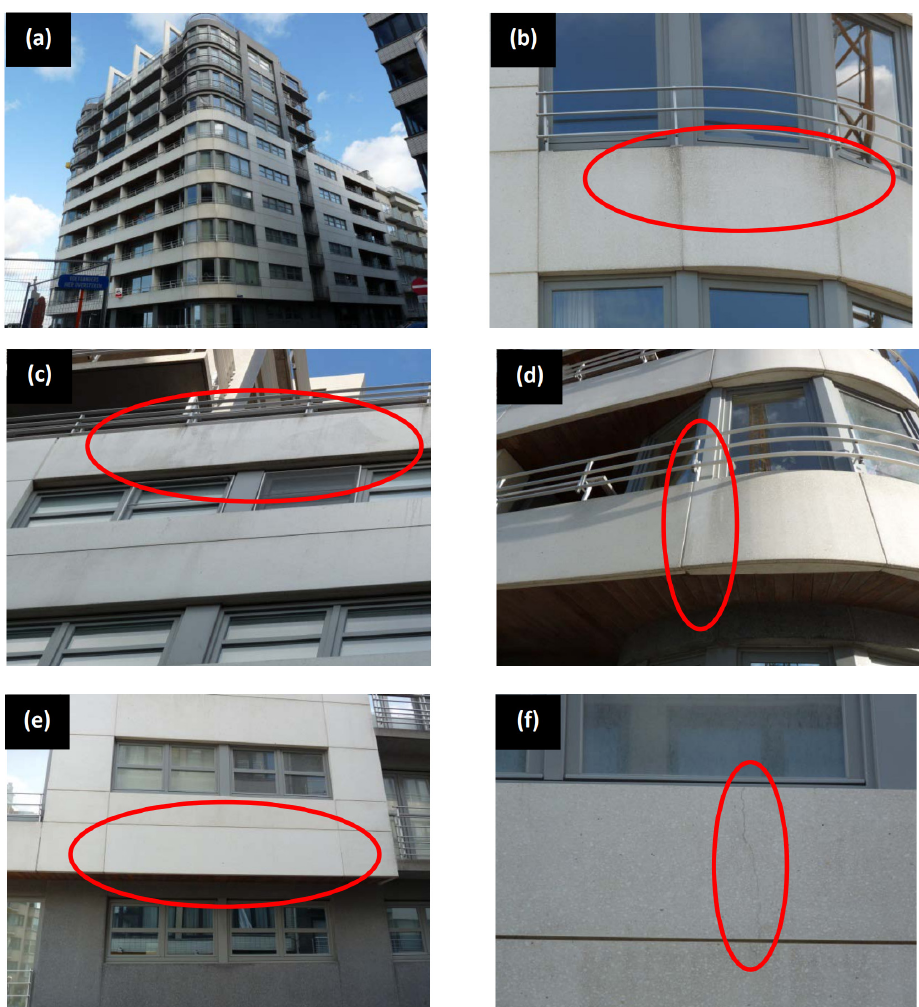
Figure 4. Residentie Commodore (Ostend, Belgium), the first Belgian self ‐ cleaning building which evidenced low photocatalytic performance after 4 years of construction [34]. ( a – c ) facade, balconies and walls evidenced dirty surfaces ( d , e ) balconies and walls evidenced different white intensities, ( f ) cracked